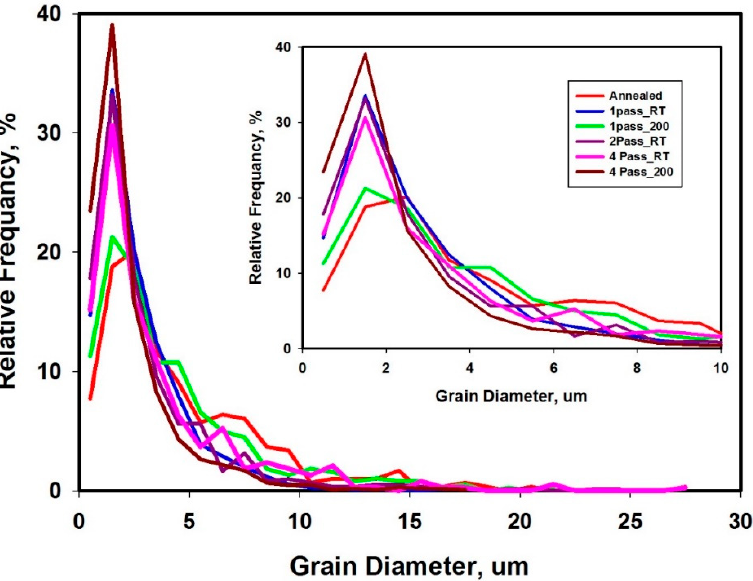
Figure 11. Relative frequency of the different grain diameters of as annealed commercial pure Cu and after ECAP processing through 1-P, 2-Bc and 4-Bc.